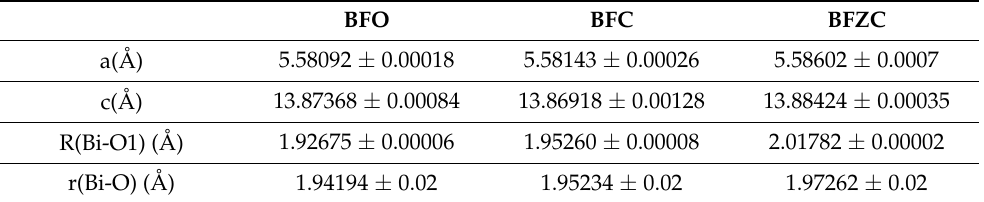
Table 1. The lattice constants a, c, and relevant bond lengths R(Bi-O) from XRD and r(Bi-O) from XAFS. BFO